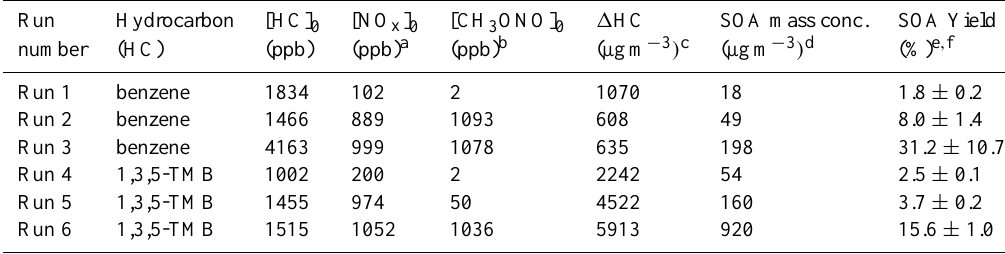
Table 1. Experimental conditions and SOA